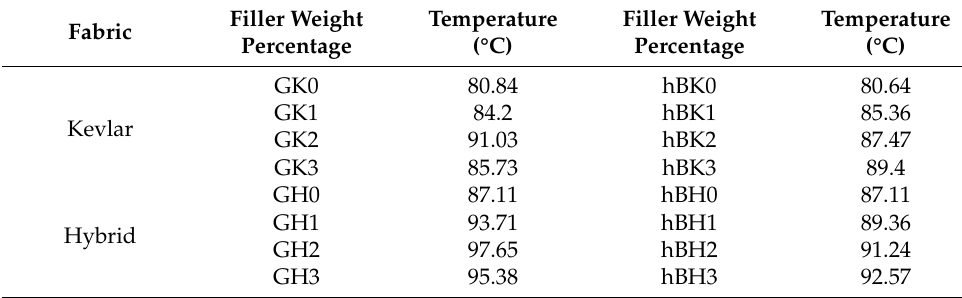
Table 9. Heat deflection values of graphene- and hBN-filled composites.